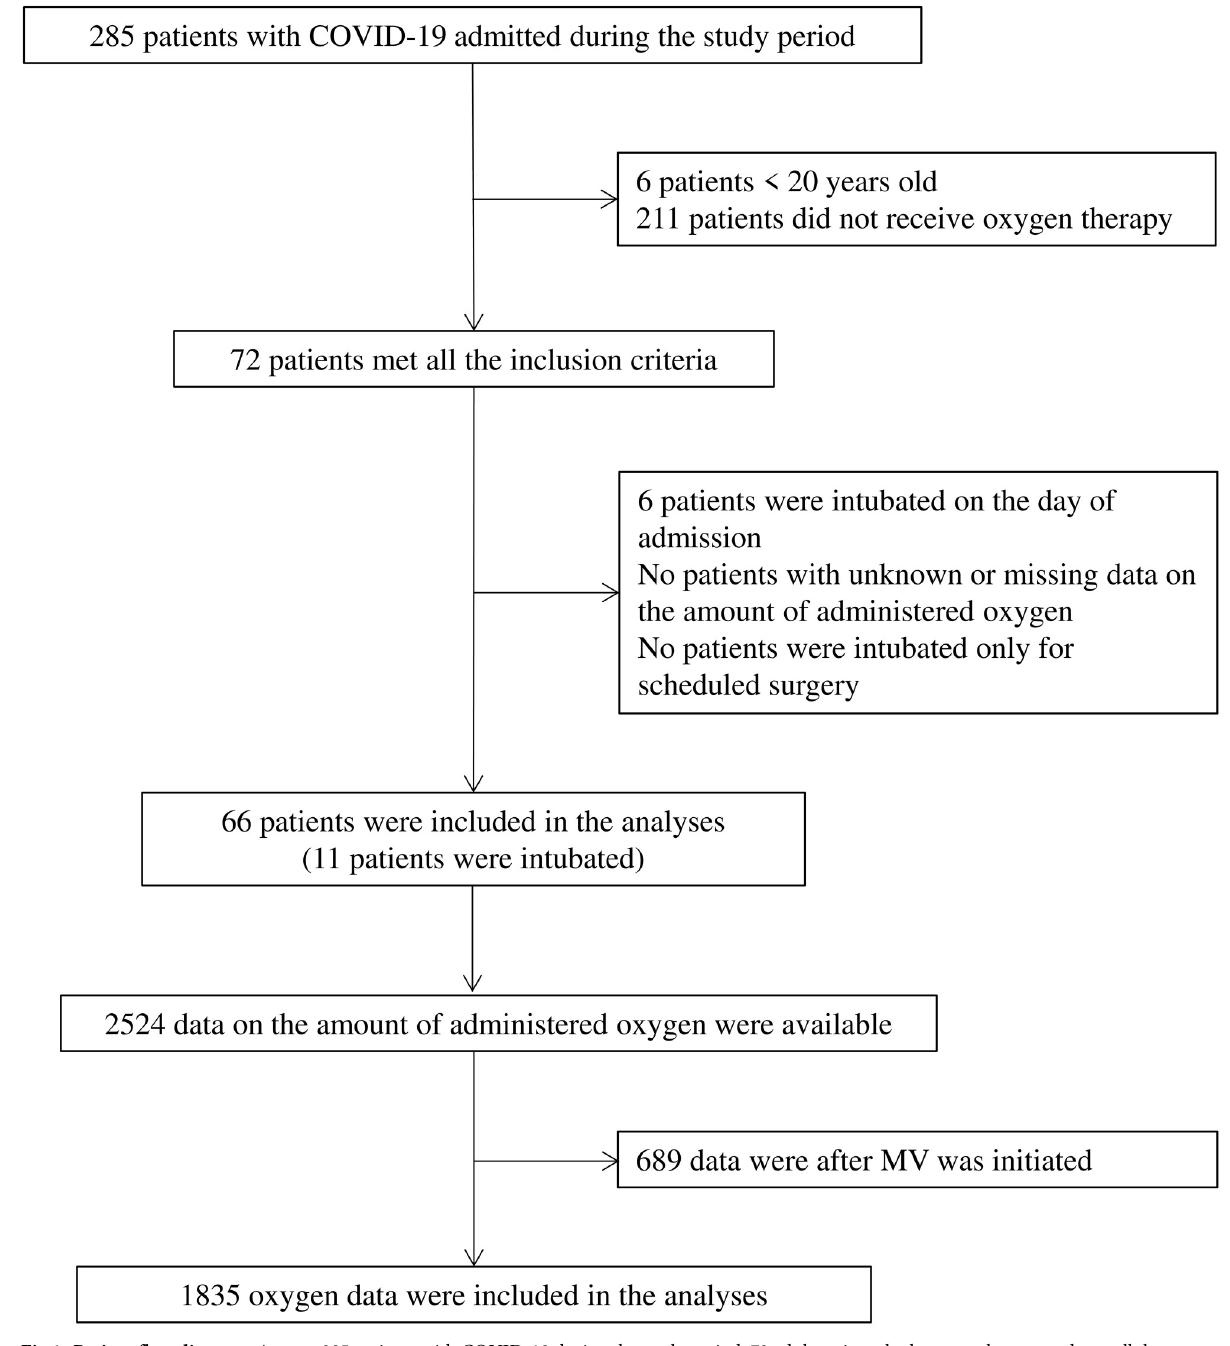
Fig 1. Patient flow diagram. Among 285 patients with COVID-19 during the study period, 72 adult patients had oxygen therapy and met all the inclusion criteria. A total of 6 patients were intubated on the day of admission, and therefore 66 patients were eligible for this study. Among 2524 oxygen data available in included patients, 689 were excluded from the analyses because they were those after MV initiation. Abbreviations: COVID-19, novel coronavirus disease 2019; MV, mechanical ventilation.